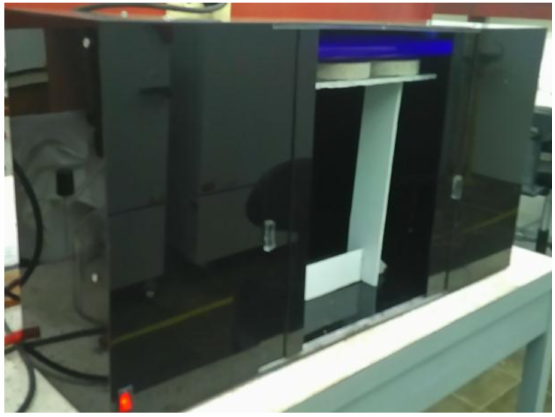
Figure 2. UV-A reactor using Electrolux T8 20W/BLB, λ = 360 nm, intensity = 10.3 W · m − 2